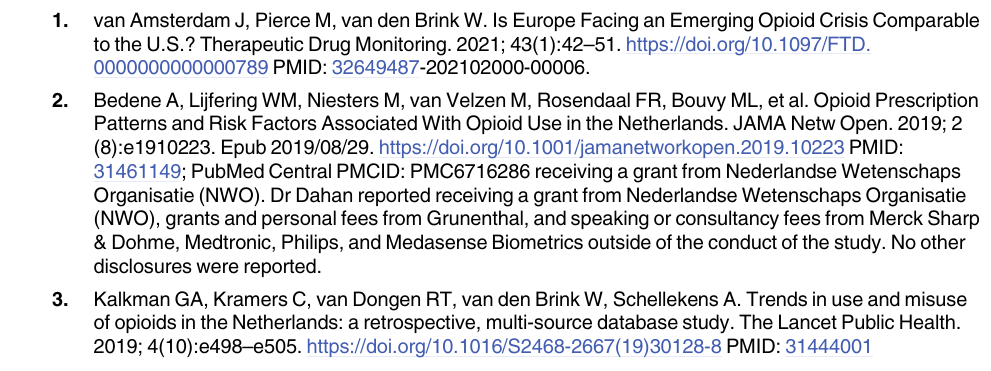
S1 Fig. Flowcharts describing the number of patients included and excluded per year. S2 Fig. Funnel plots for outcomes from 2017 and